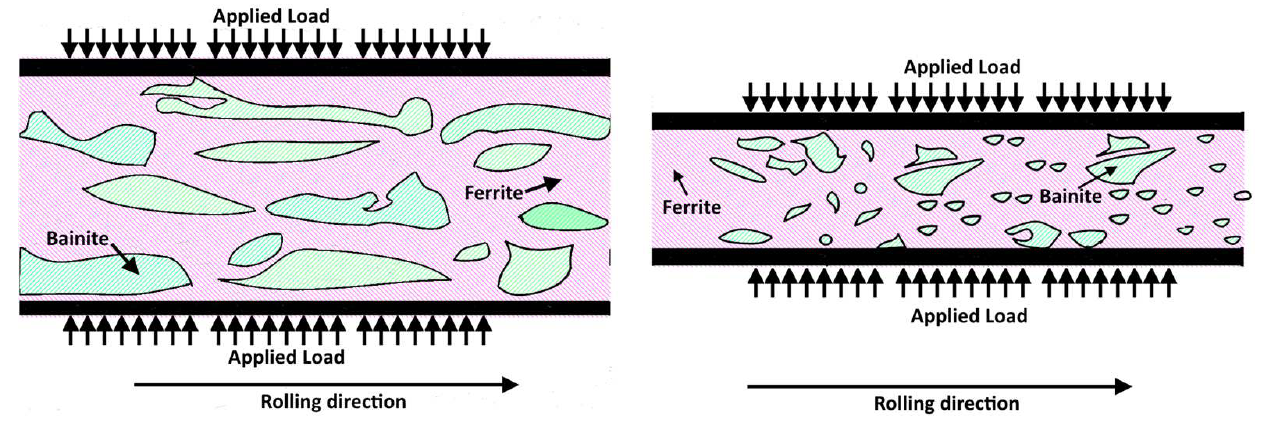
Figure 14. Schematic showing the change in shape and organization of bainitic islands in ferrite matrix passing from 20 to 50% strain hardening level.